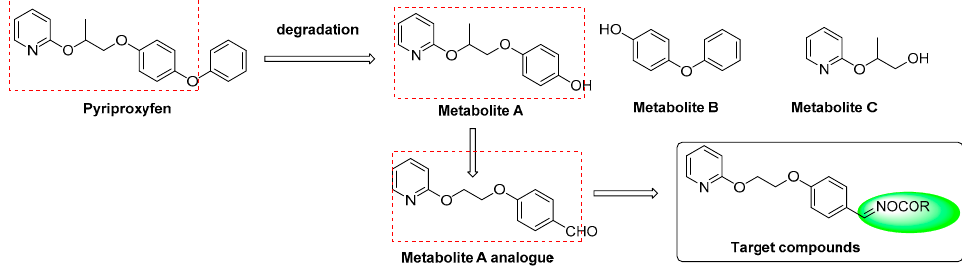
Figure 2. Molecular structure of the target compounds.